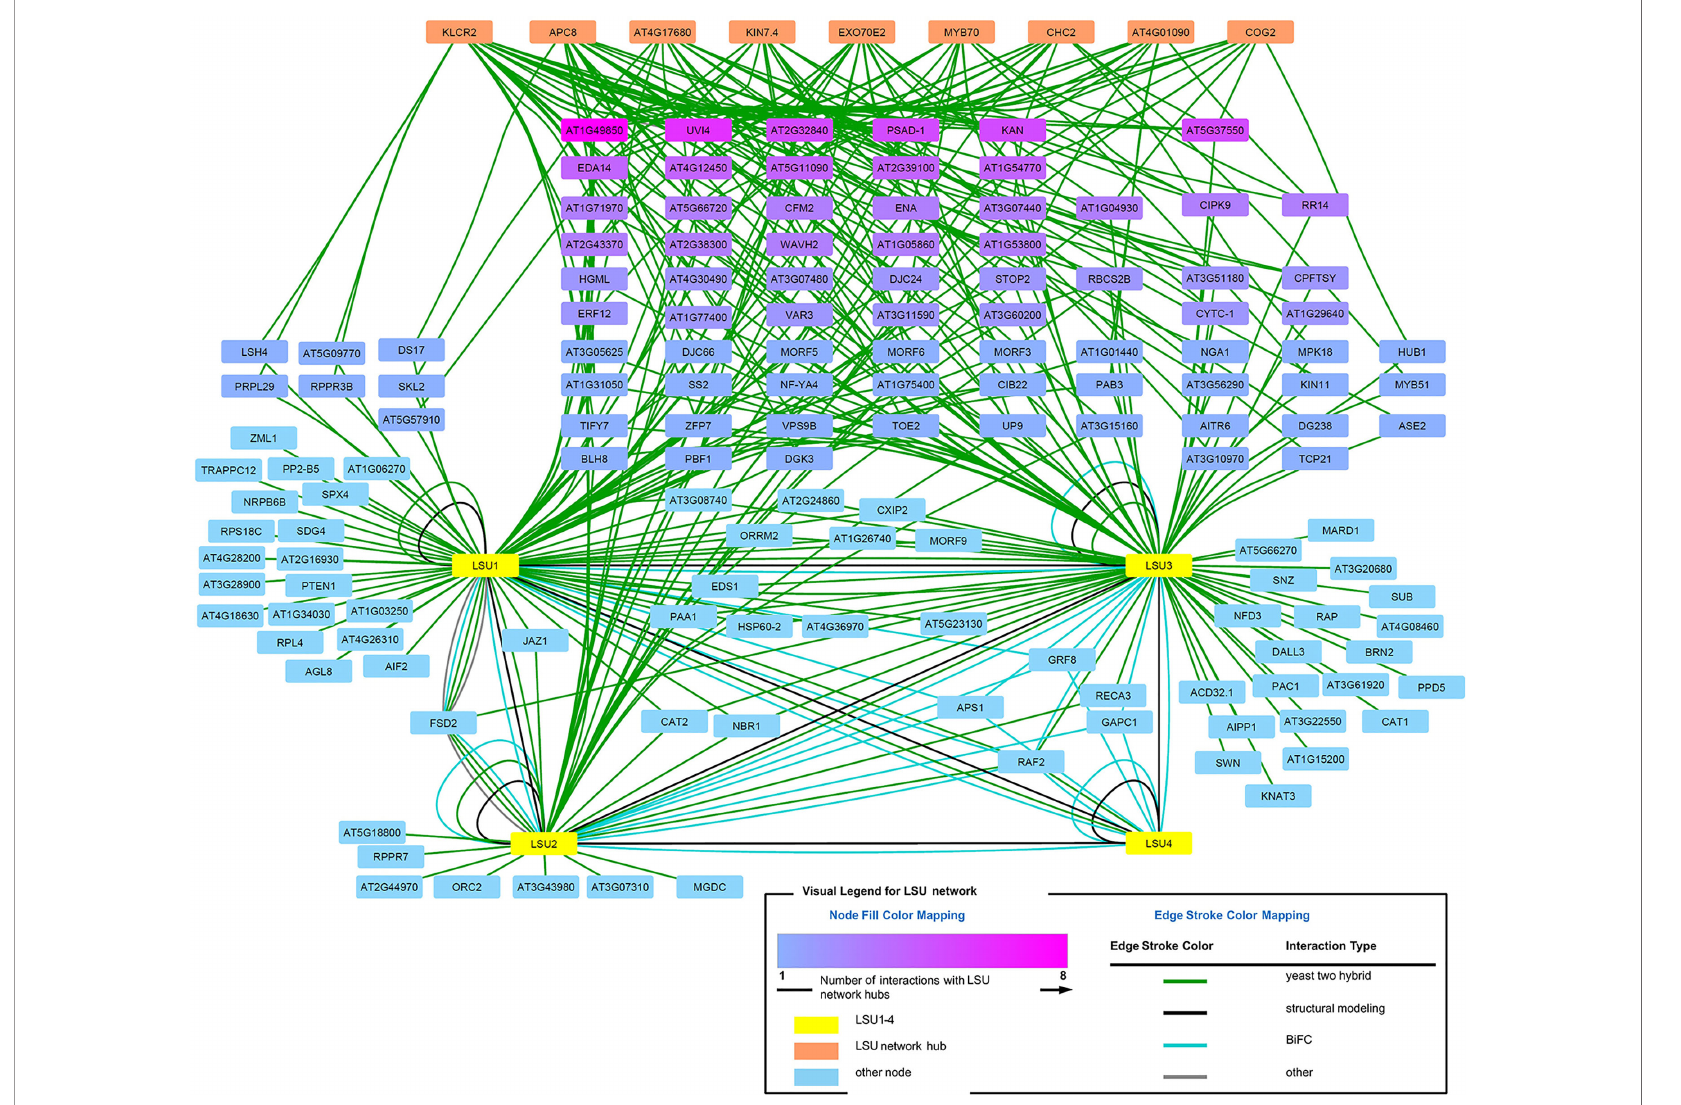
FIGURE 8 | LSU interaction